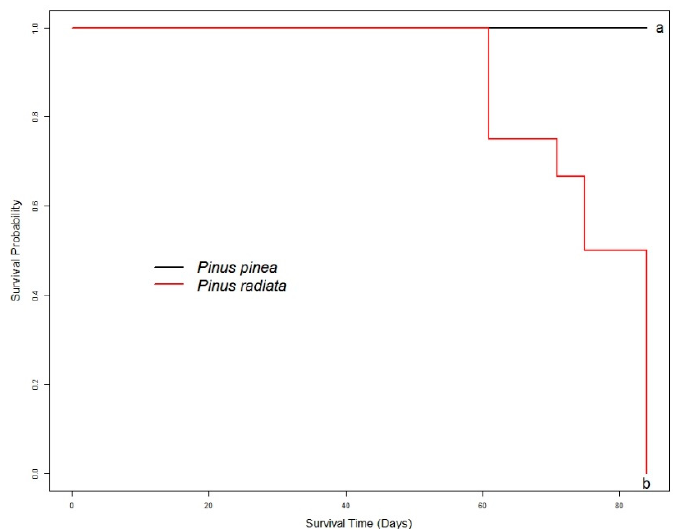
Figure 1. Survival probability plot determined using the Kaplan–Meier estimate of the survival function for P. pinea and P. radiata seedlings inoculated with F. circinatum . Different letters indicate significant p-values.